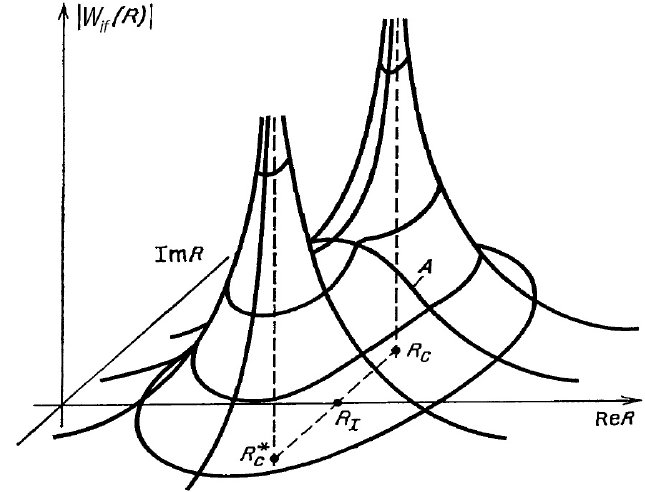
Figure 2. The matrix element of non-adiabatic coupling W if ( R ) in the complex R -plane. ( R ) at real value of R . From Curve A is W if